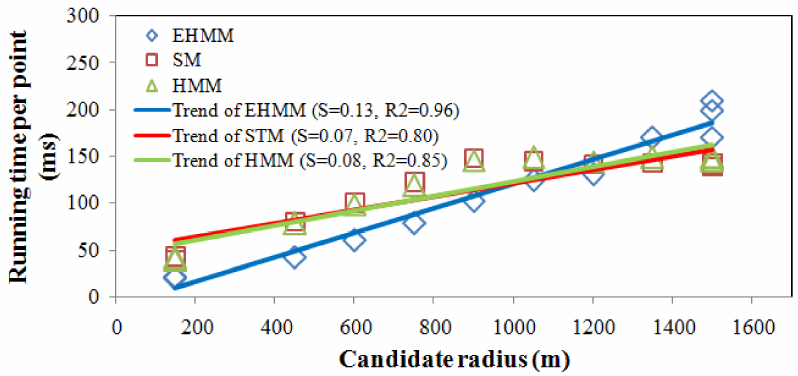
Figure 10. Influence of the candidate radius on running